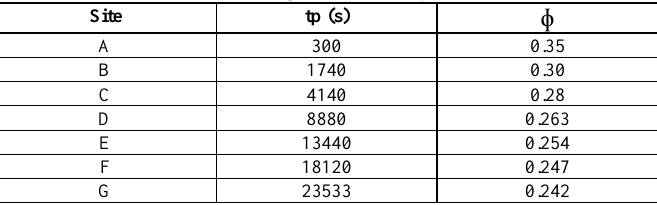
Table 2: Resulting values of equation (25).